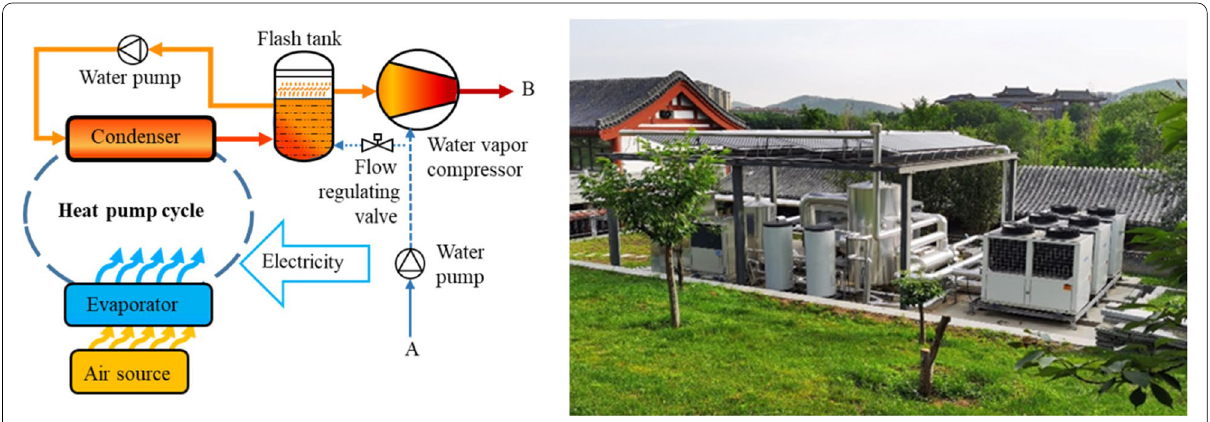
Fig. 6 Air source heat pump for steam generation [13]